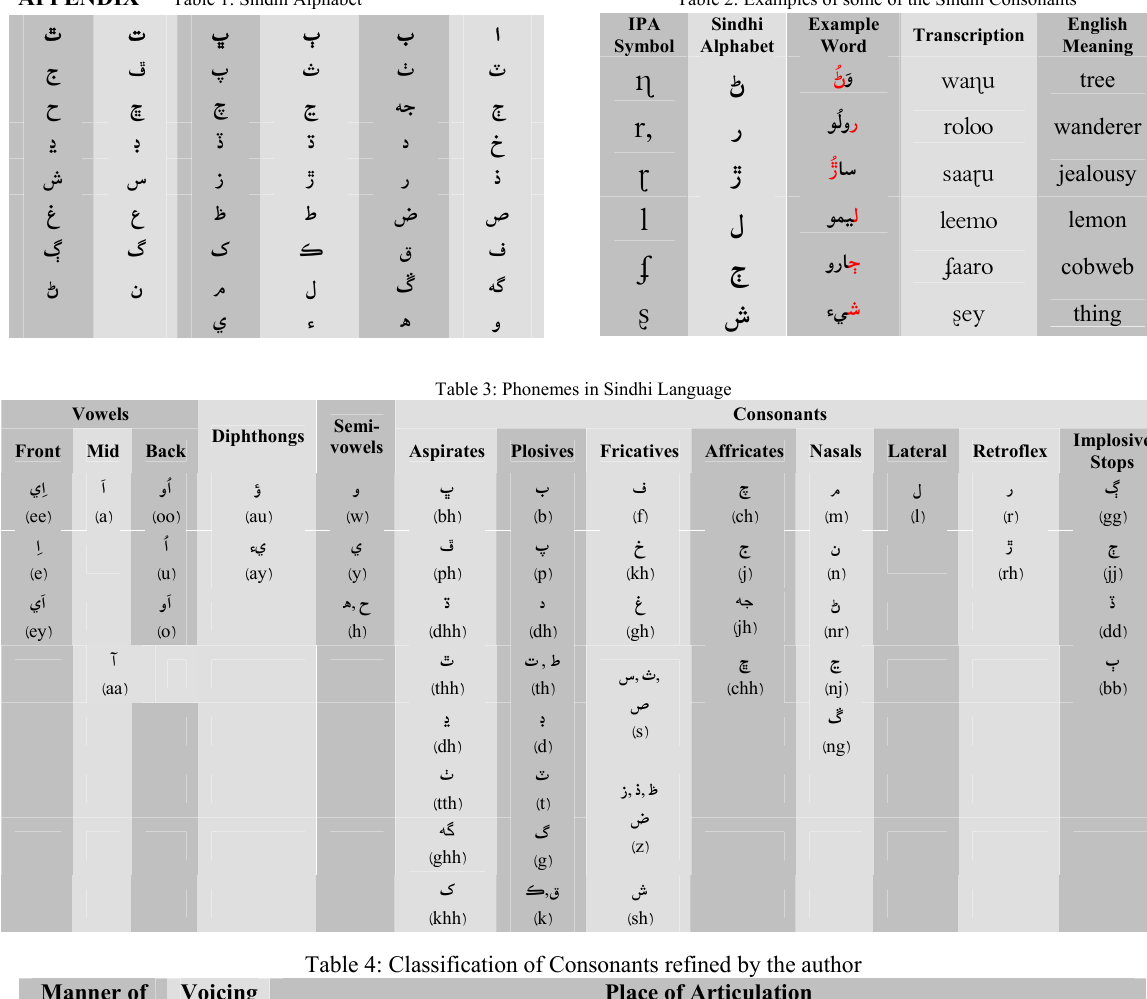
Place of Articulation Manner